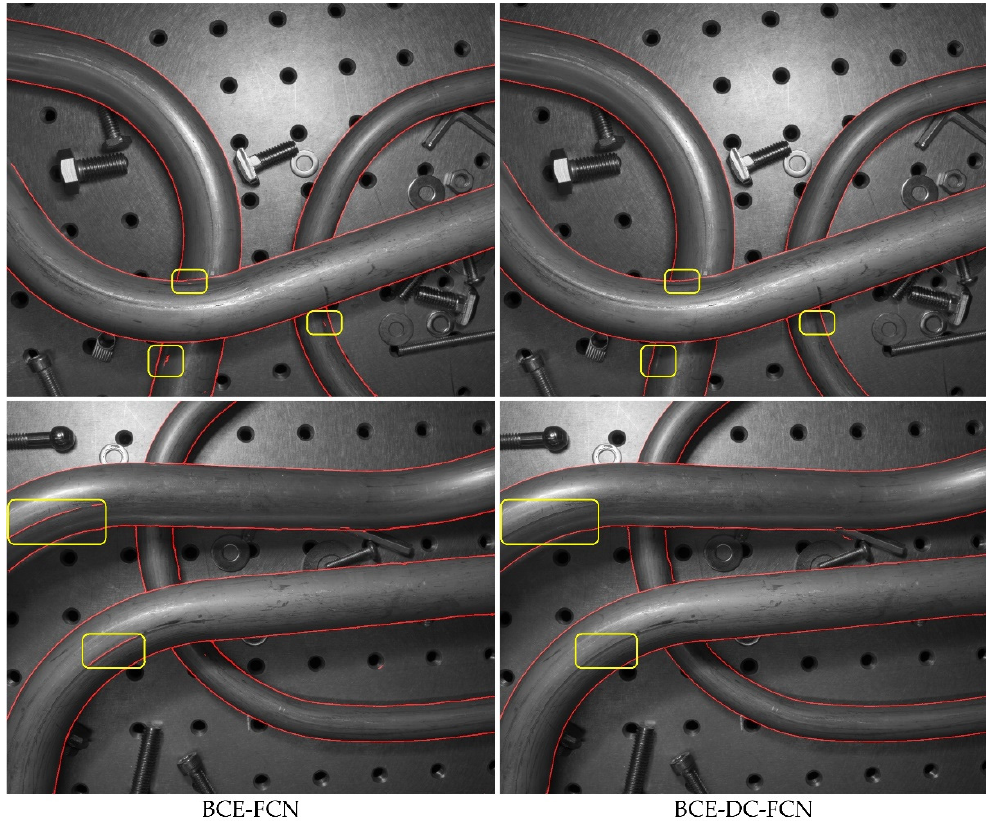
Figure 12. Tube contour detection results on several samples. The images in the left column were produced by an FCN model that was trained with BCE loss, and in the right column were produced by an FCN model that was trained with BCE-DC loss.